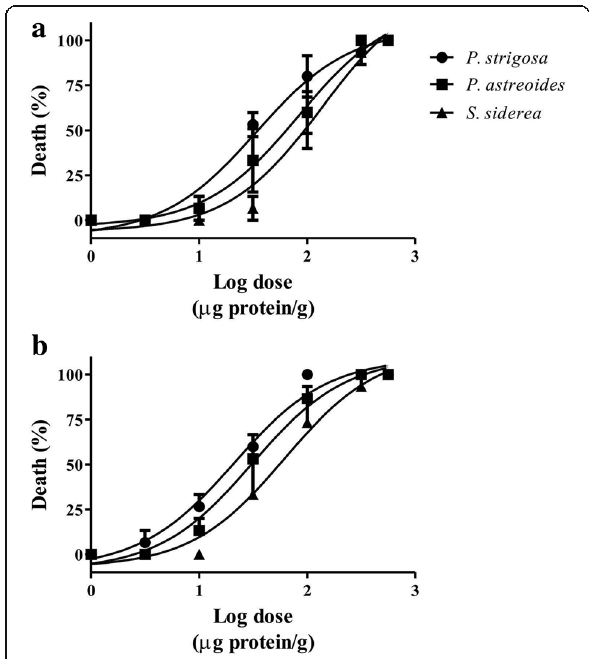
Fig. 1 Toxicity of the extracts to crickets ( A. domestica ). Log-dose response curves at ( a ) 24 h and ( b ) 48 h post-injection